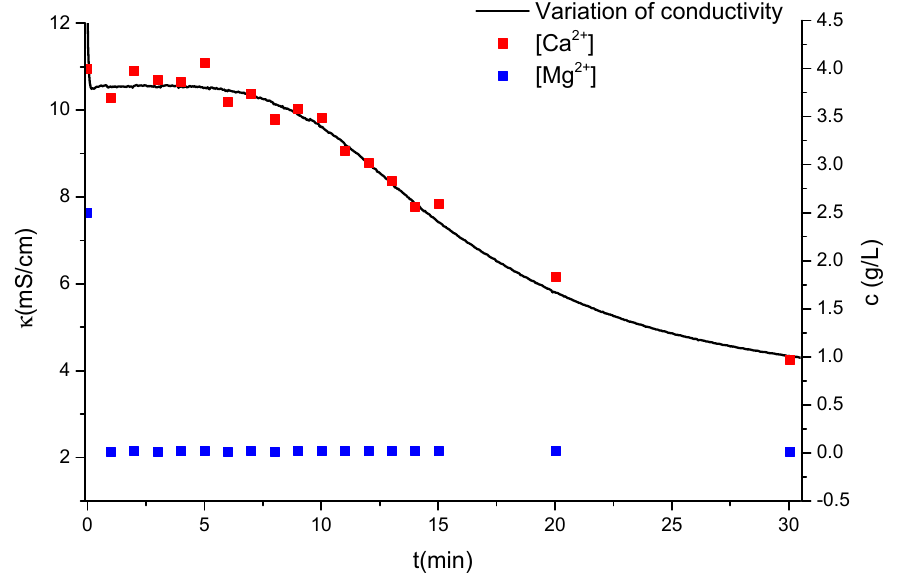
Figure 2. Comparison of the results of in situ conductivity measurement (left Y axis) and ICP-OES measurements (right Y axis); latter were performed on samples of filtered mother liquors taken during the stoichiometric reaction of MgSO 4 + Ca(OH) 2 → Mg(OH) 2 + CaSO 4 · 2H 2 O with identical (0.1 M) initial reactant concentrations, containing 1.5-mM citric acid inhibitor in distilled water (initial ionic concentrations were calculated from the weight of the added salts; T = 20 °C; in distilled water media without any supporting electrolyte).